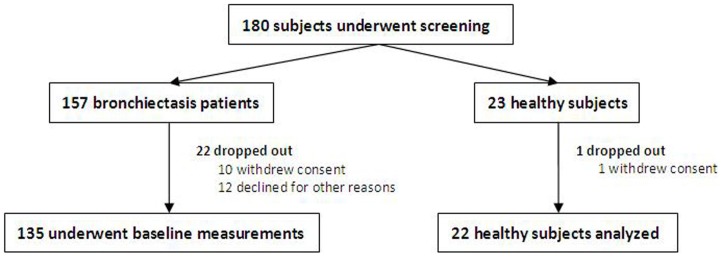
Subject recruitment flowchart.We screened 180 subjects (157 bronchiectasis patients and 23 healthy subjects). Of these, 22 bronchiectasis patients and 1 healthy subjects dropped out, and finally the data of 135 bronchiectasis patients and 22 healthy subjects were analyzed.